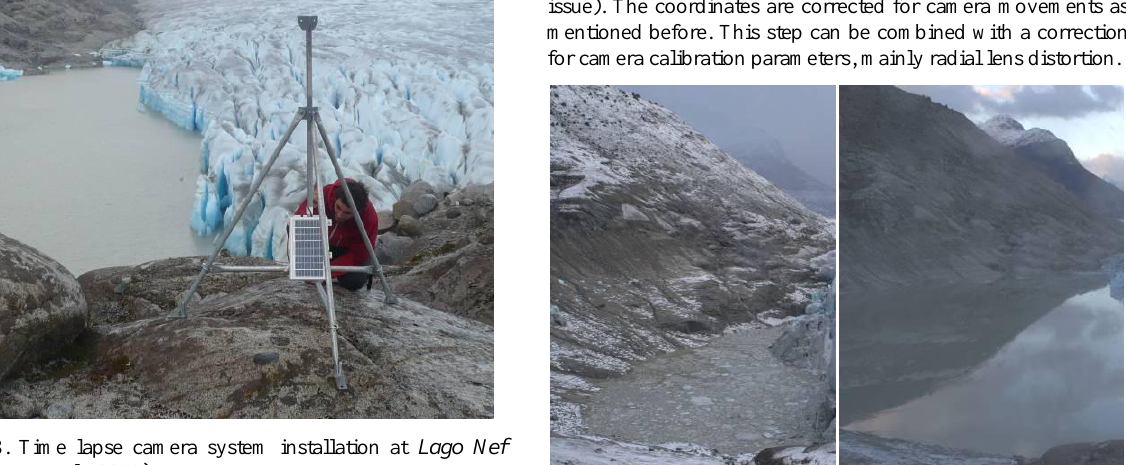
Determination of the water line in the images: In the initial phase of the project, some tests were conducted to measure the water line automatically. Unfortunately, up to now no automatic procedure turned out to be reliable enough. The main reasons are changing light conditions, ice on the water, reflections on the water surface and sediments in the water (see figure 10).